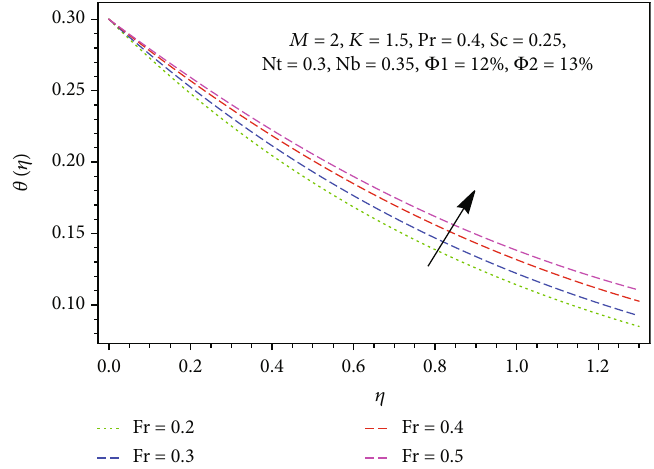
Figure 14: In fl uence of local inertial parameter Fr over energy pro fi le θ ð η Þ